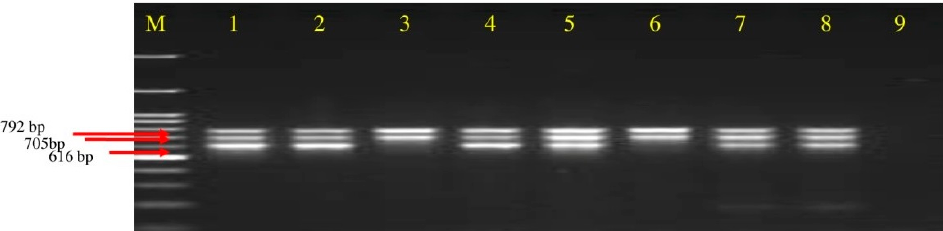
Figure 5. Detection of Bacillus species from soil samples collected from different states of India by using multiplex- PCR based on polyketide antibiotic synthase genes i.e., difficidin, macrolactin and